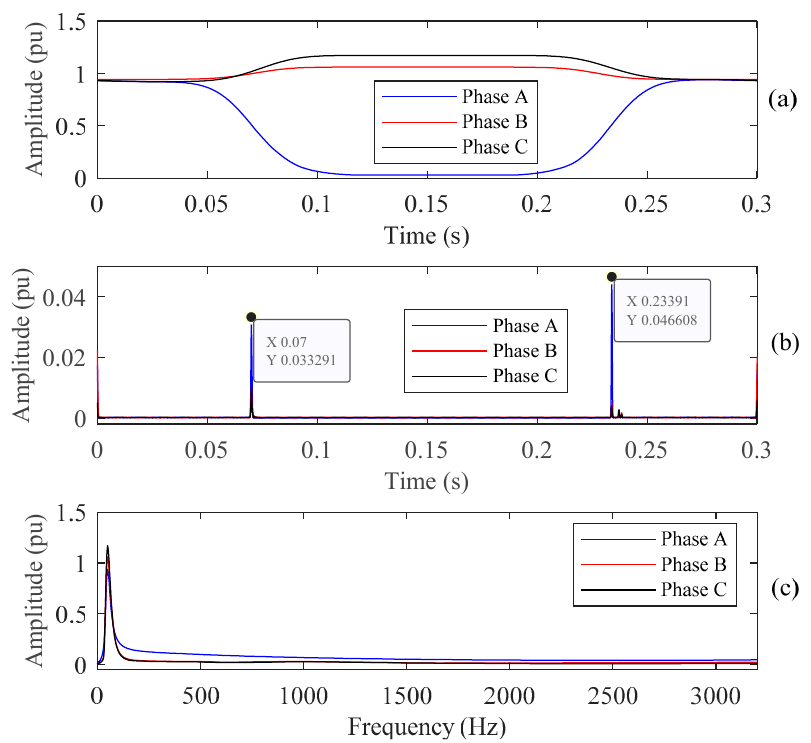
Figure 13. Related STA plots of PQ event when phase A to ground fault occurs at F.2: ( a ) TvA ; ( b ) TvHFA ; ( c ) FvA.